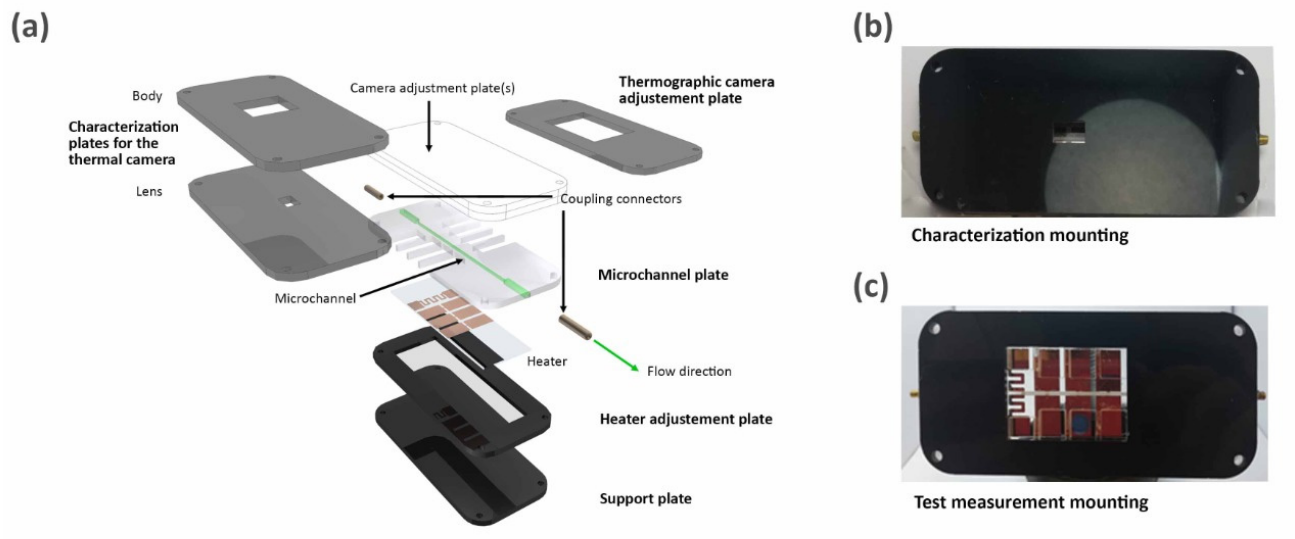
Figure 2. ( a ) Microsystem building diagram and final mounting photographs of ( b ) test measure- ment and ( c )